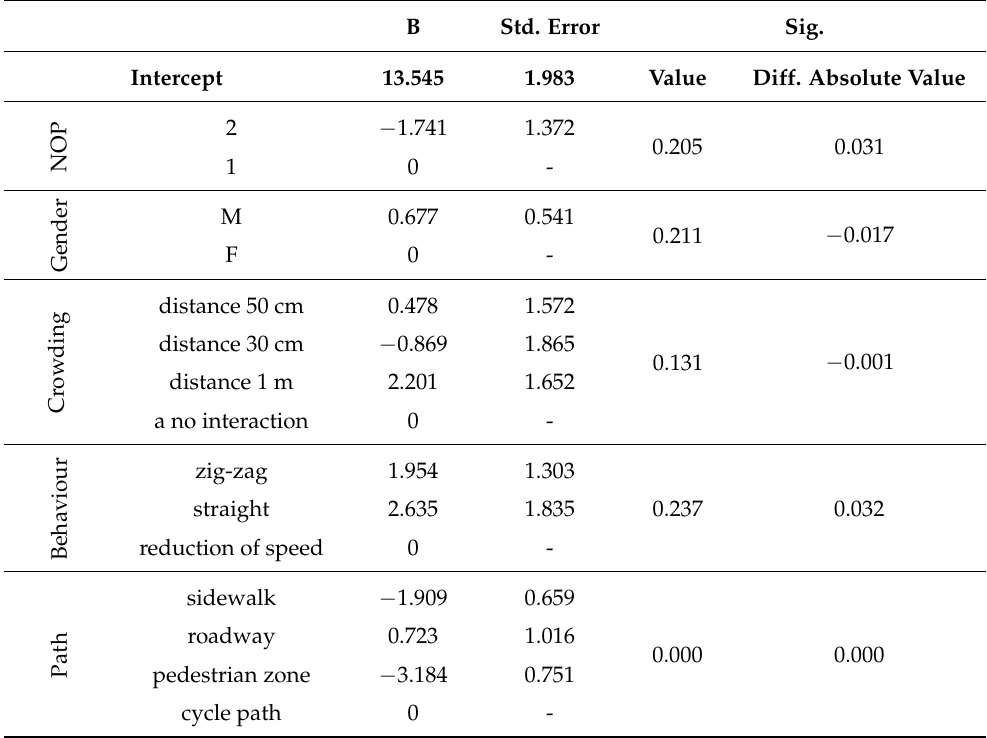
Table 3. Test of model effects without street, Addinfo, and age. B Std. Error